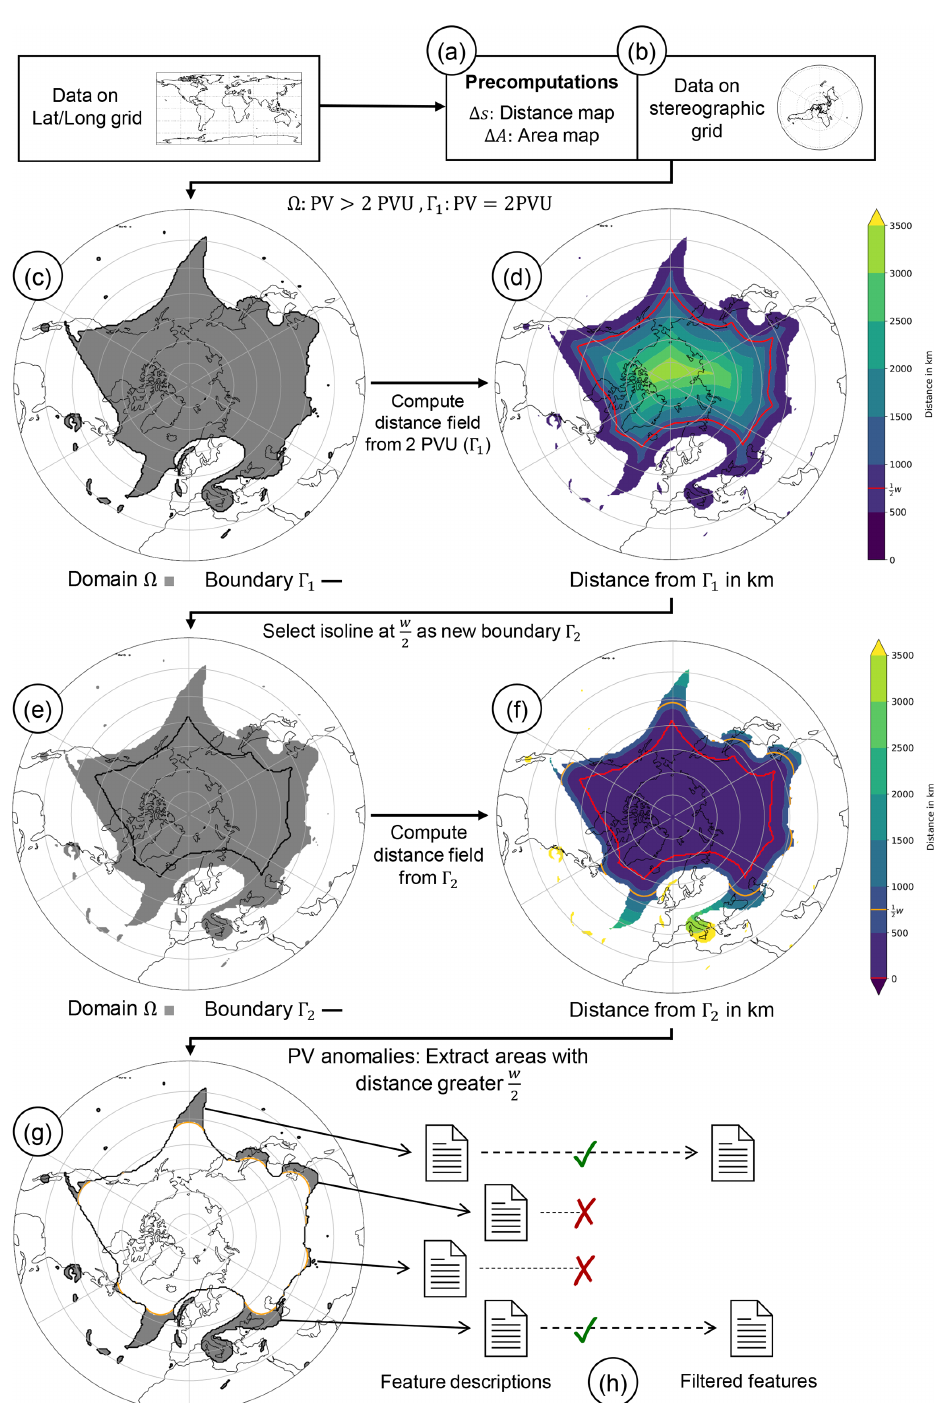
Figure 4. Illustration of the algorithm to identify PVSs. (a,b) Input data are mapped to a stereographic grid; precomputations are performed. (c,d) The distance field from the 2PVU boundary is computed (cf. Sect. 3). Points at a distance equal to half the width threshold w denoted by the red isoline. (e,f) From this isoline, distances outwards are computed. Again, the isoline corresponding to w respect to the new distance field (orange). (g) Regions with a distance greater than w (h) The anomalies are labeled and filtered, yielding a set of identified PVSs. Visualized is the 335K isentrope from the ERA5 reanalysis on 7 September 2016,